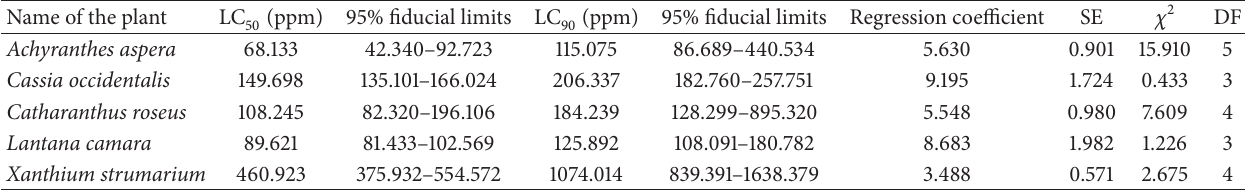
Table 3: Larvicidal potential of the stem hexane extracts of the selected plant species against early fourth instars of dengue vector Aedes aegypti . Name of the